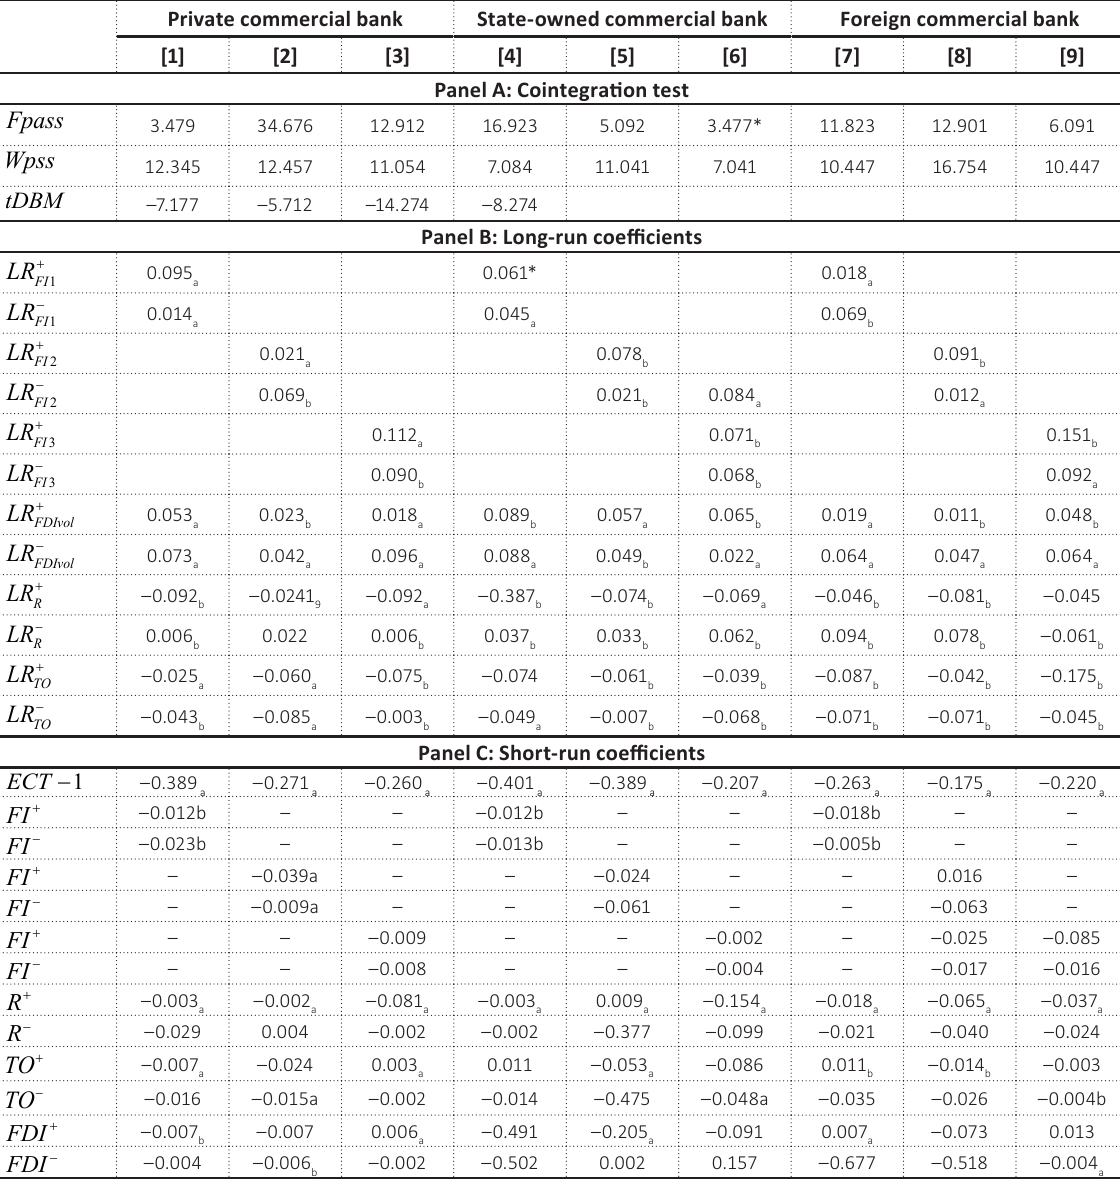
Table 7. NARDL model estimation